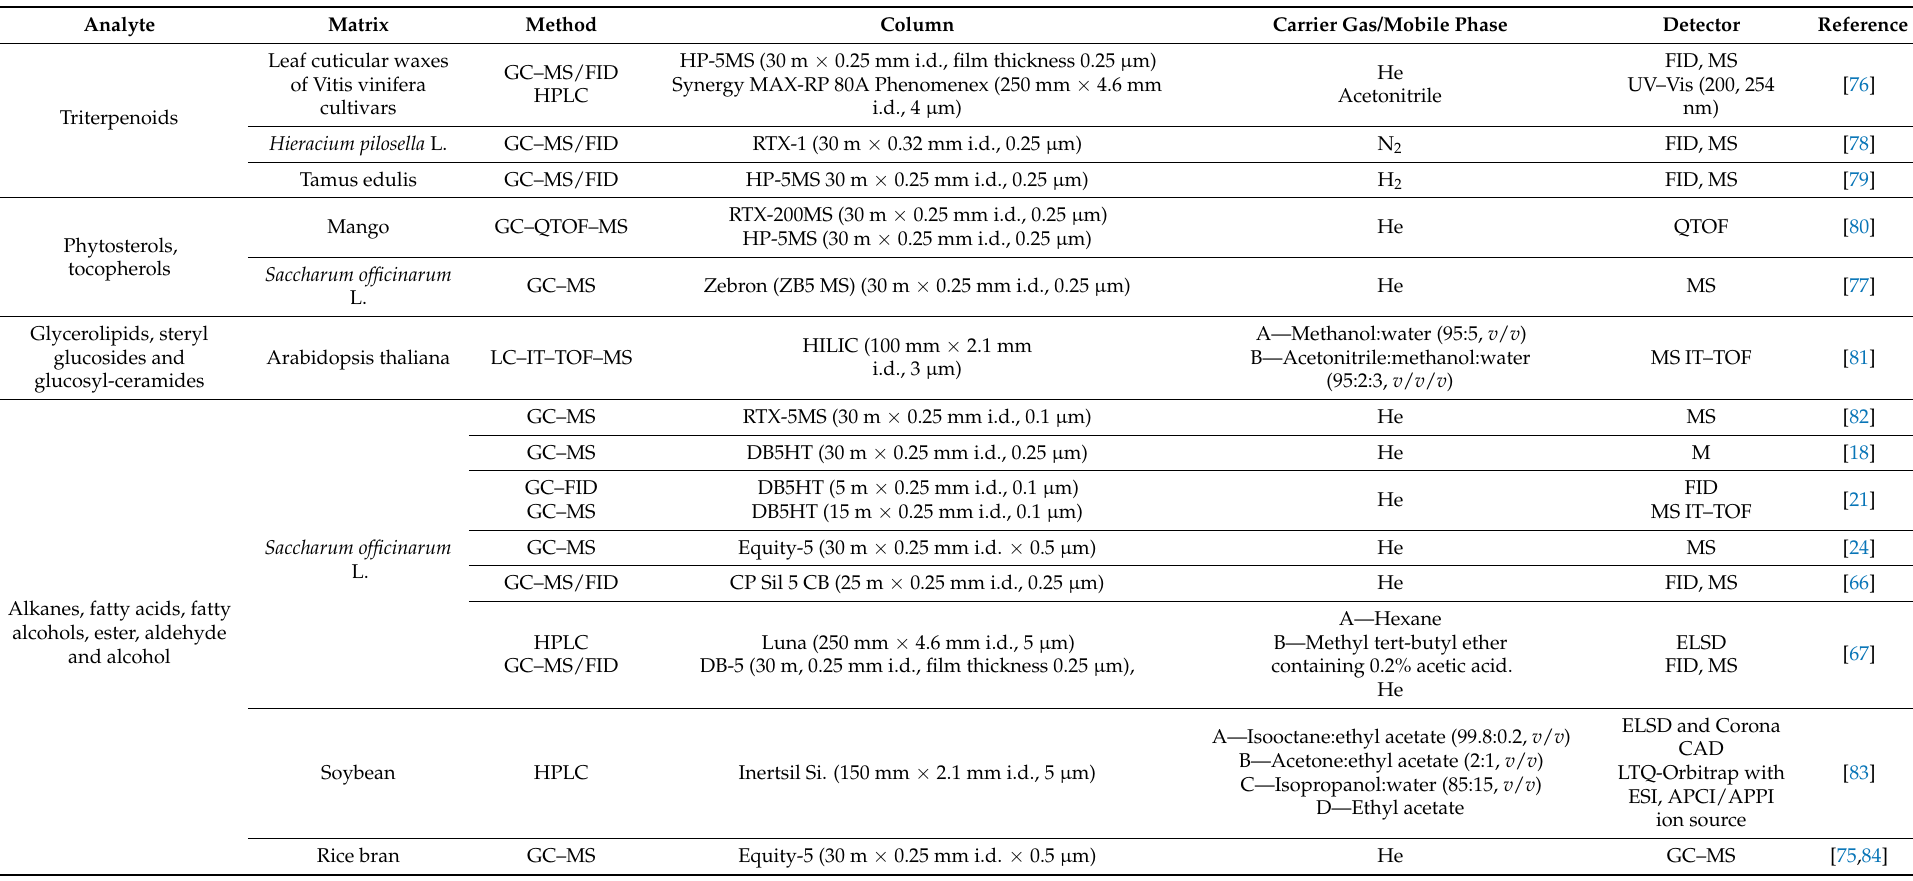
Table 2. Lipophilic plant analysis characterization